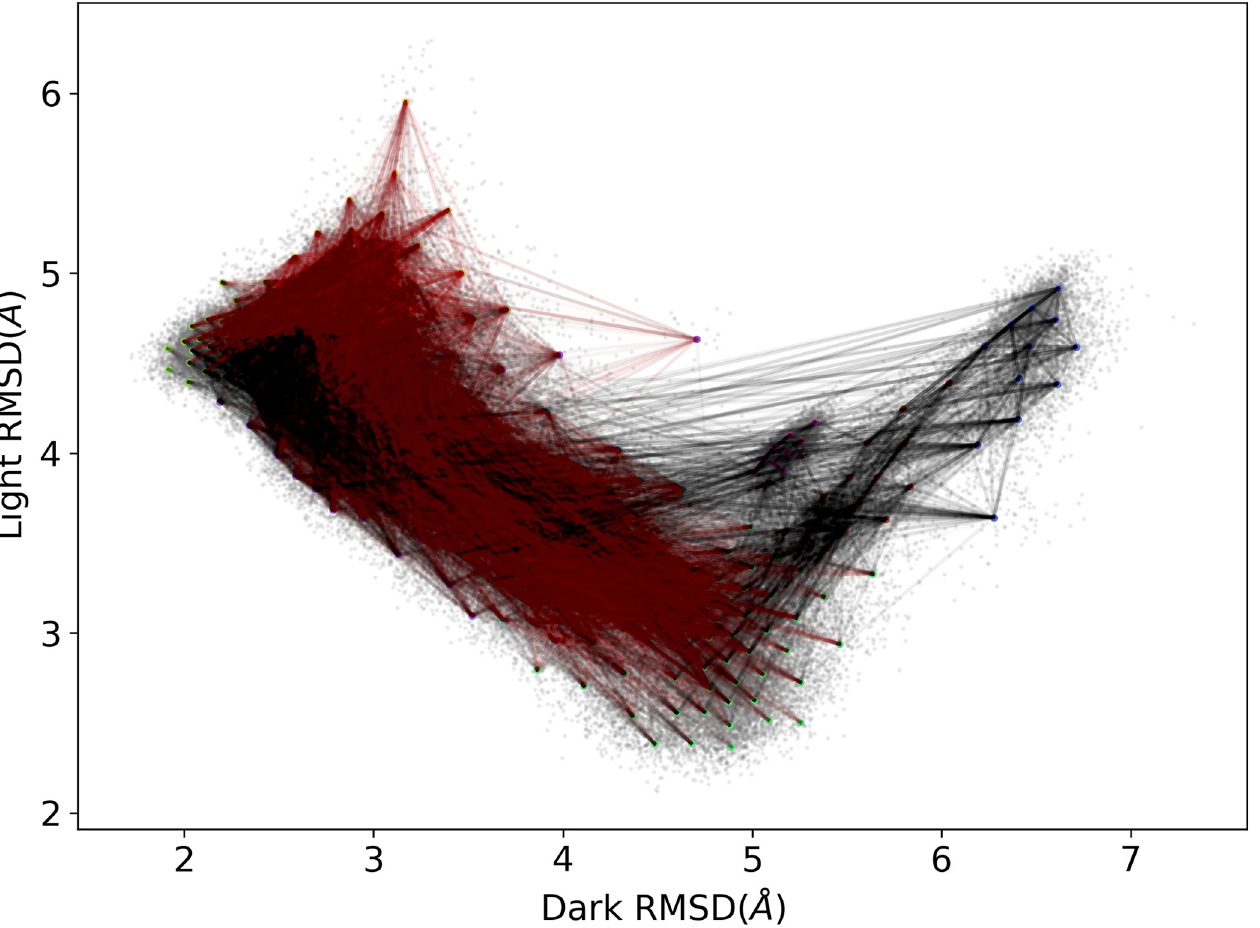
Fig 10. 10,017 pathways generated from state 3 to state 4 based on transition pathway theory (TPT). The 3–2–7–5–4 pathway is the third most populated pathways with around 15% contribution and plotted in red. This suggests that the loop regions in Commu. B play an important role during the transition between dark and light states, because the correlations between Commu. B and Commu. C/D contribute significantly to the differentiation between states 3 and 2 as well as states 2 and 7.